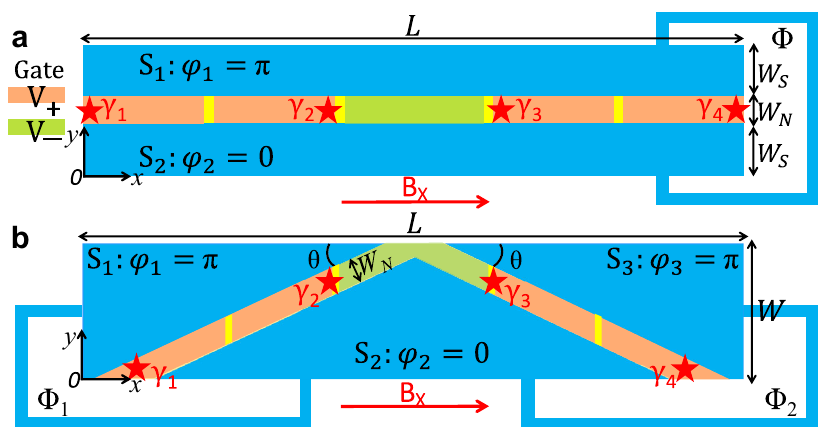
Fig. 2 Setup. a Straight and b V-shaped junction (SJ, VJ) formed by superconducting, S 1,2,3 , regions (blue), partially covering a 2D electron gas (yellow). The electron density in the uncovered part is locally tuned using mini-gate voltages, V 1,2,3,4,5 (left to right). With a magnetic fi eld B x and superconducting phases, φ 1,2,3 , controlled by the external fl uxes Φ , Φ 1 , Φ 2 , the chemical potential of the normal region, μ N , is locally changed to support topological (orange) and trivial (green) regions, by imposing the mini-gate voltage V + and V − . MBS γ 1,2,3,4 (stars) form at the ends of the